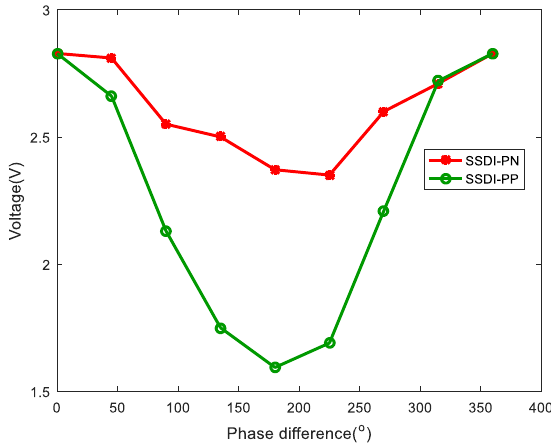
Figure 16. Response vs. phase difference (degree) of excitation.